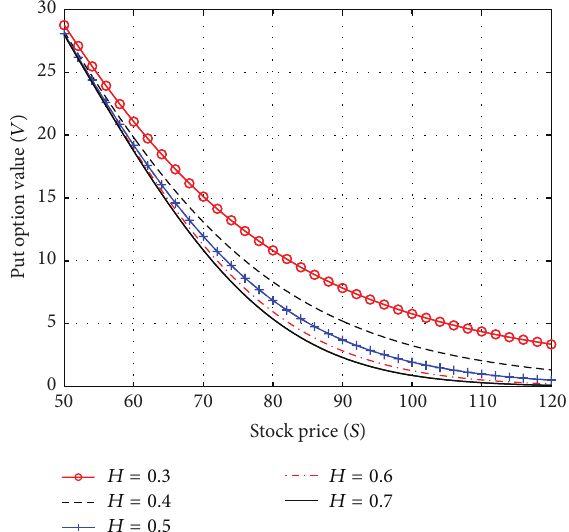
Figure 2: Asian put option pricing corresponding to the different 𝐻 .